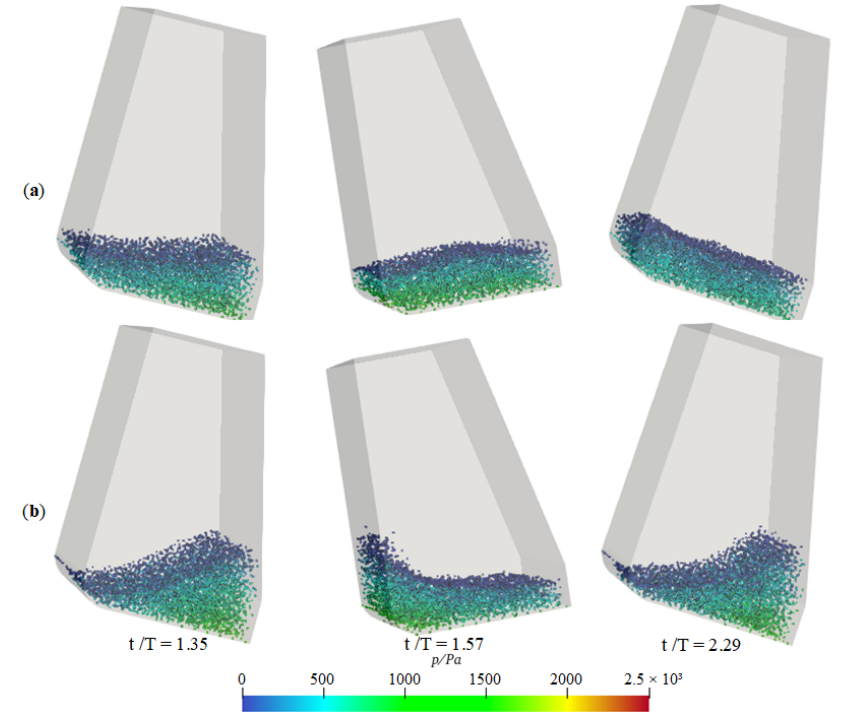
Figure 9. Snapshots of flow field in different rolling periods. ( a ) case 3; ( b ) case 4.